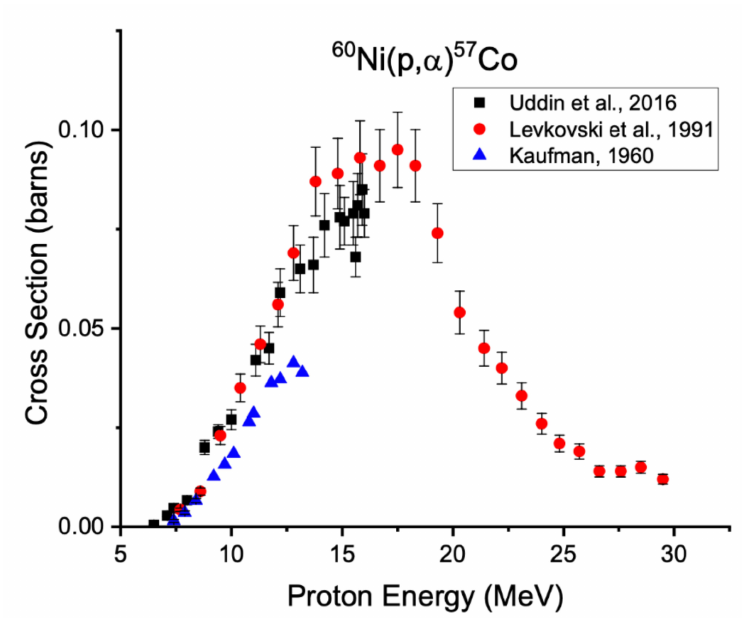
Figure 10. Excitation functions for production of cobalt-57 from nickel-60 [24,32,68].